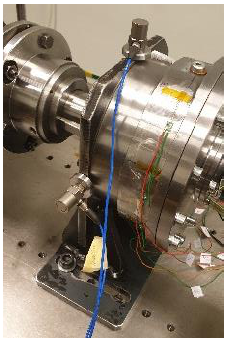
Figure 3. Placement and direction of installation of accelerometers.